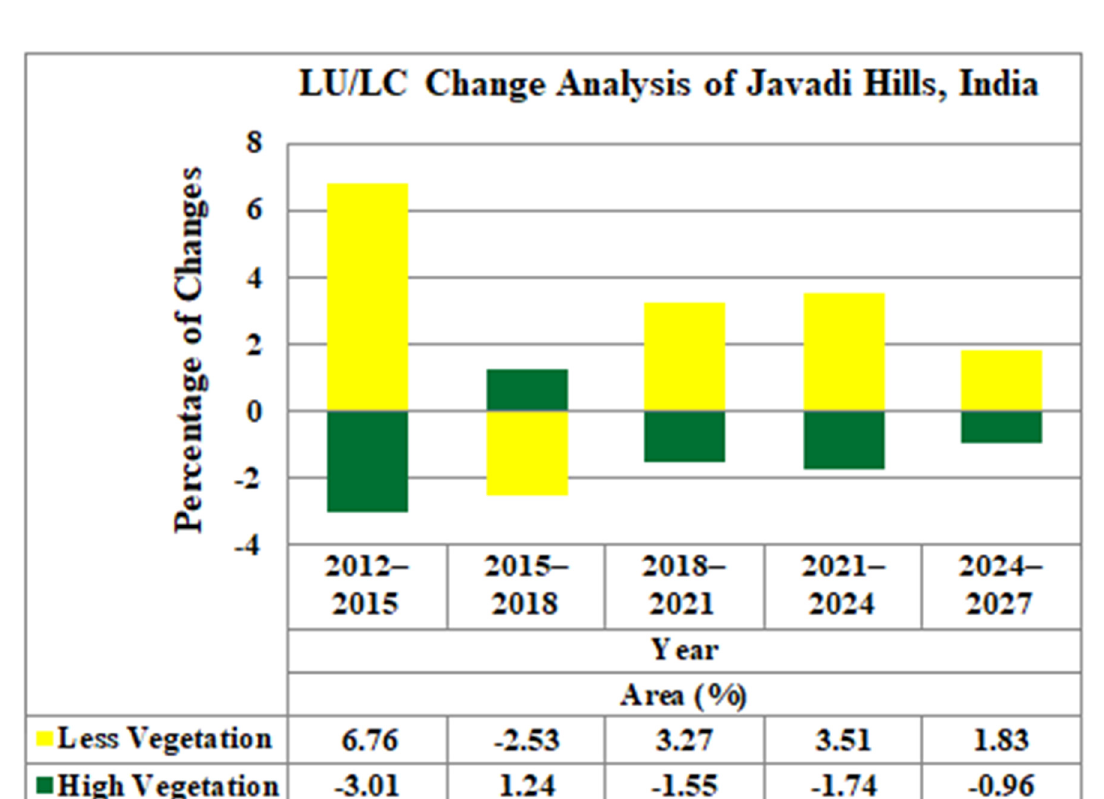
Figure 21. LU/LC change analysis of the Javadi Hills, India (2012–2027). Table 10. Percentage of LU/LC change for the area of Javadi Hills during 2012–2027. LU/LC Class